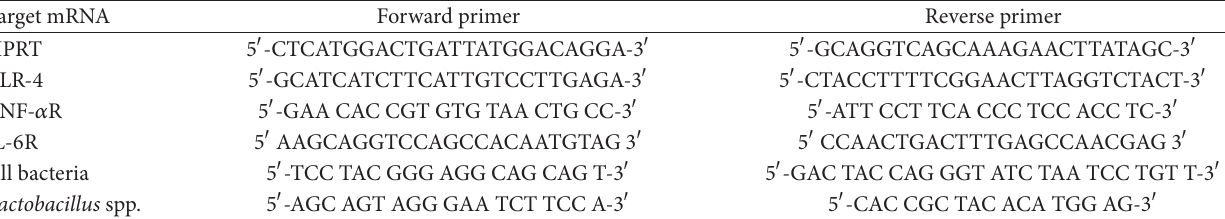
Table 2: Nucleotide sequence of the forward and reverse primers for the RT-PCR.